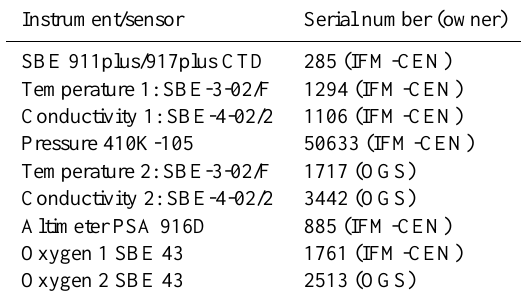
Table 2. CTD instrument and sensors used. Owners of instruments are either the University of Hamburg, Germany (IFM-CEN) or the National Institute of Oceanography and Geophysics (OGS),